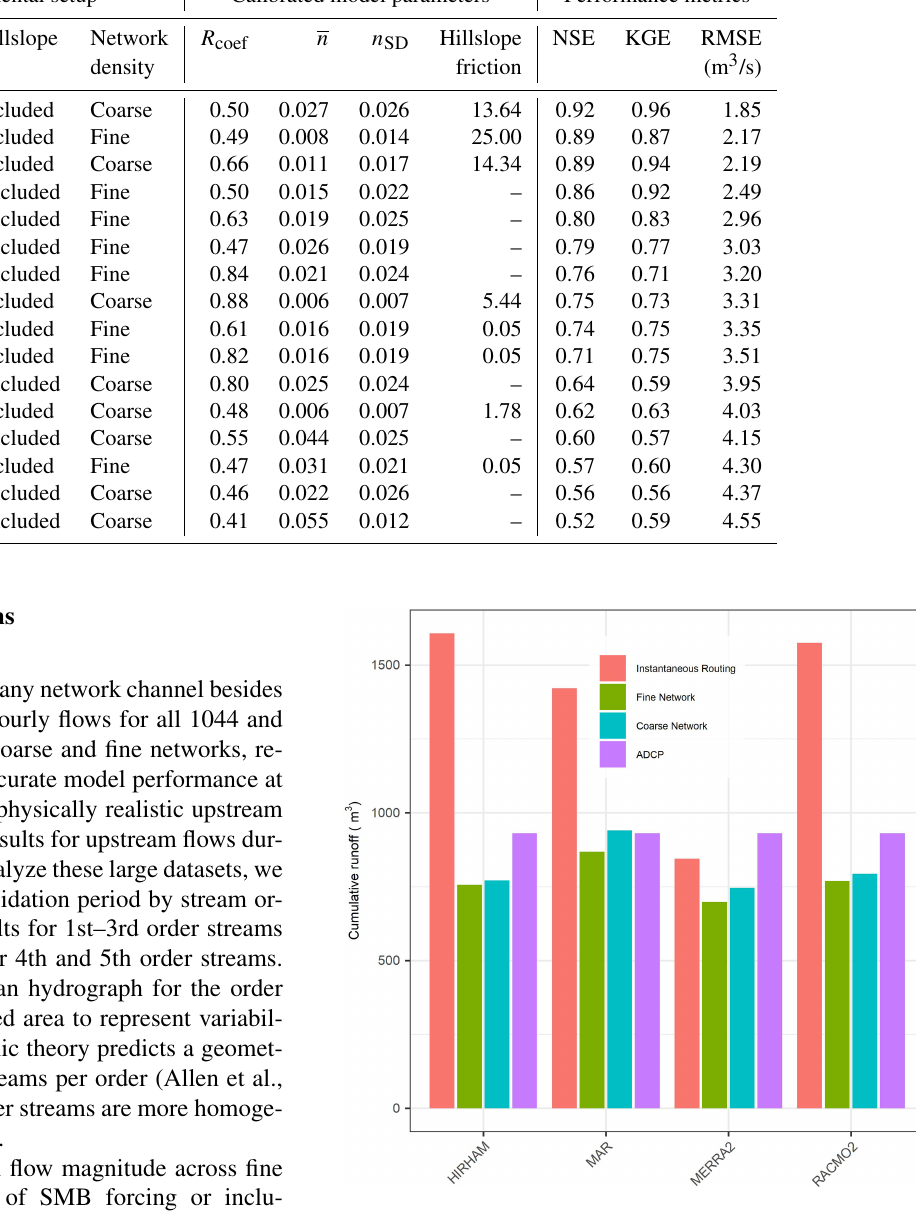
Figure 4. Total cumulative discharge for hillslope-enabled scenar- ios for the 72h ADCP measurement period. Total water export is relatively consistent across all four SMB models but substantially different than input runoff (i.e., instantaneous routing) for all mod- els but MERRA2. The ADCP represents a measured cumulative ex- port, while instantaneous routing assumes that SMB runoff immedi- ately leaves the watershed as soon as it is produced. Calibrated mod- els underpredict water export due to the underestimation of night- time low